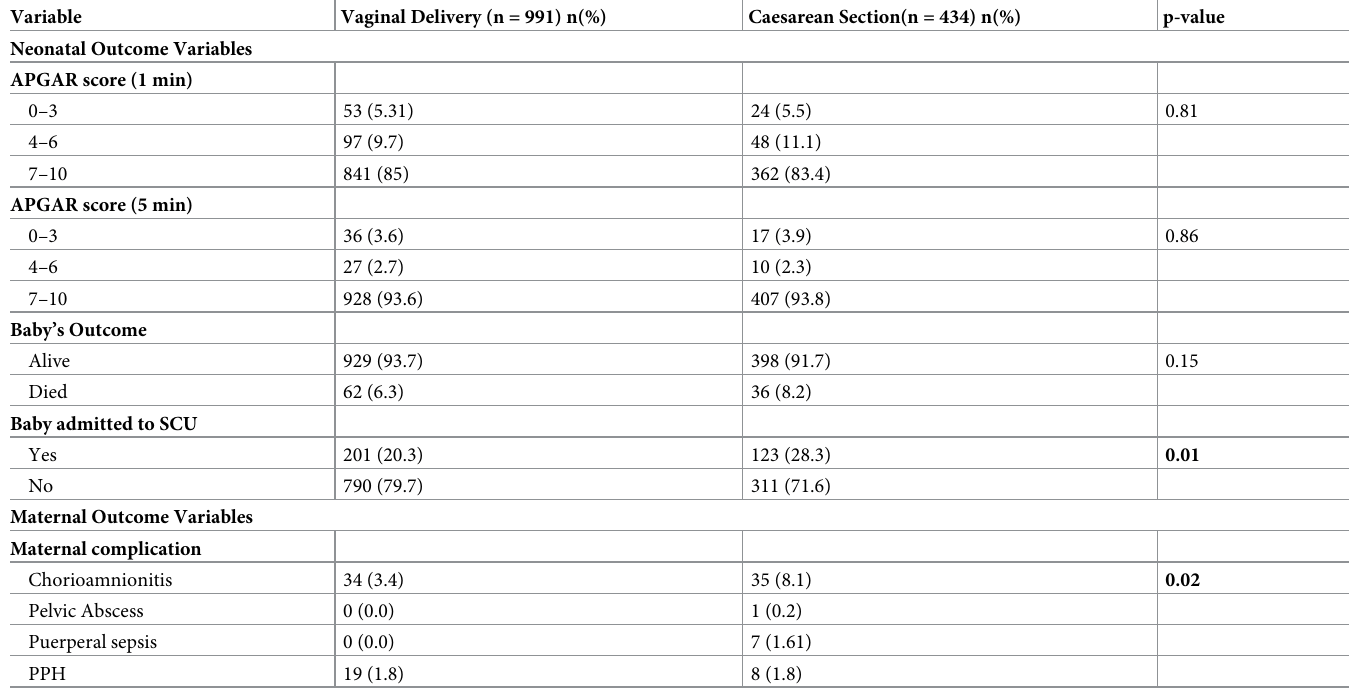
Table 2. Comparison of maternal and neonatal outcomes between vaginal and caesarean section at Mulago Hospital. Variable Vaginal Delivery (n = 991) n(%) Caesarean Section(n = 434) n(%)